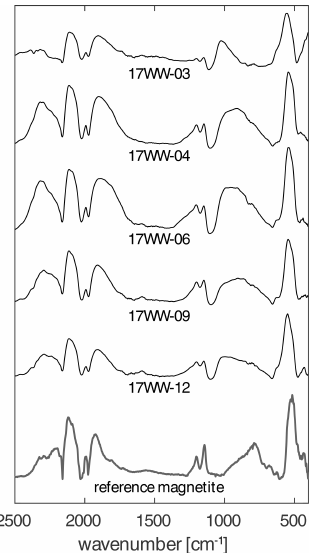
Figure 3. Baseline-corrected attenuated total reflection Fourier- transform infrared (ATR-FTIR) spectra of powdered samples, showing a known magnetite sample (bottom) and unscreened mag- netic separates from five different depths. These spectra demon- strate that the sample material is composed of magnetite (Fe 2 O 3 ) without any detectable contribution from other phases. This method is not sensitive to substitution of Fe by other